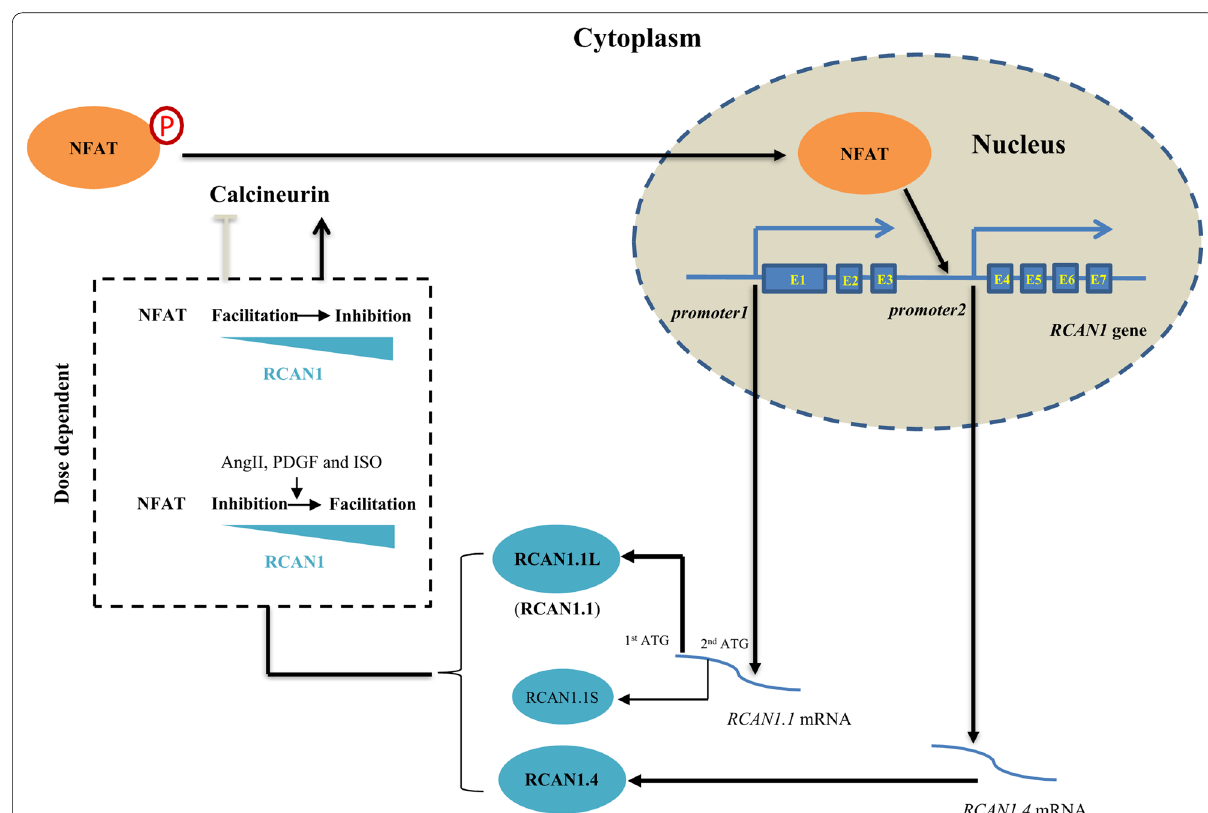
Fig. 1 The bidirectional role of RCAN1 in calcineurin/NFAT signaling pathway. The RCAN1 gene consists of seven exons (presented as E1–E7). RCAN1.1 (E1, E5–E7) and RCAN1.4 (E4, E5–E7) are the two major transcripts, which are generated by alternative promoter using and splicing. Two isoforms, RCAN1.1L (252 amino acids) and RCAN1.1S (197 amino acids), are generated from RCAN1.1 by alternative usage of two in-frame translational start codons (presented as 1st ATG and 2nd ATG). As RCAN1.1L is the dominant isoform of RCAN1.1, hence RCAN1.1 hereafter stands for RCAN1.1L. RCAN1.4, another relative abundant isoform is translated from RCAN1.4 . Each isoform participates in calcineurin-NFAT signaling by regulating calcineurin-mediated NFAT dephosphorylation, while active NFAT facilitates RCAN1.4 transcription. RCAN1 plays complex roles in the regulation calcineurin-NFAT signaling in a dose-dependent manner. Low level of RCAN1 is essential for the maintenance of calcineurin-NFAT signaling while high dose of RCAN1 exerts inhibitory effect on calcineurin-NFAT signaling. However, in response to AngII, PDGF or ISO treatment, RCAN1 functions as an inhibitor of calcineurin-NFAT signaling when its level is low, but as a facilitator of calcineurin-NFAT signaling when its level is high. The arrowhead stands for positive regulation, while T-shaped end stands for inhibition. P within the red circle represents the